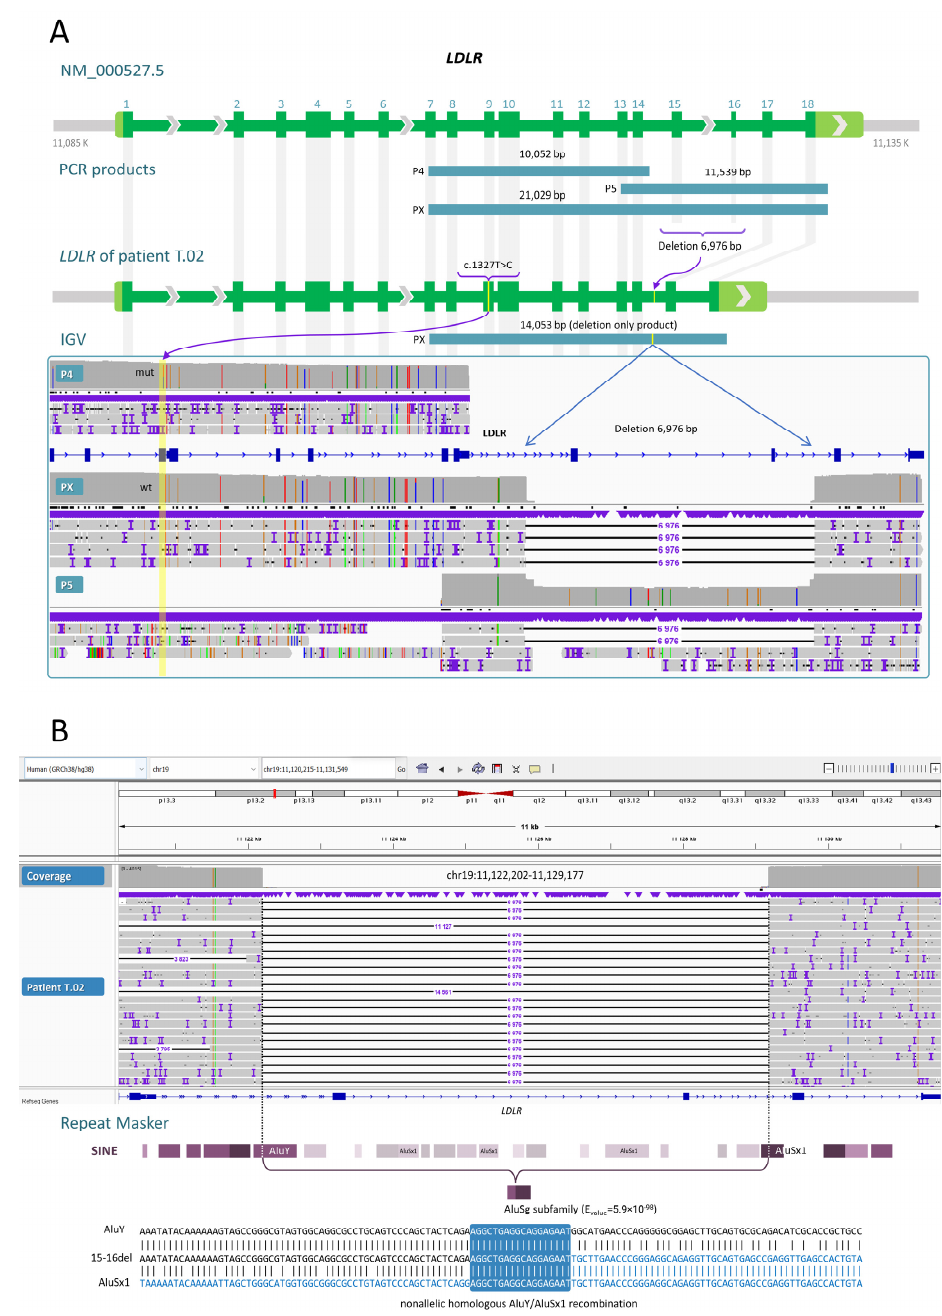
Figure 3. A snapshot from the IGV software showing the rare pathogenic variants of the LDLR gene in the T.02 sample. ( A ) ONT long reads identify a heterozygous state of the 6976 bp deletion that includes exons 15 and 16 (the amplicon of primer pair P5). Detection and phasing of missense variant c.1327T>C (wt/mut) relative to the 6976 bp deletion (amplicons of primer pairs P4, P5, and PX); ( B ) The precise location of breakpoints of the 6976 bp deletion and its DNA sequence are shown. The allele with the 6976 bp deletion has a higher probability of amplification with primer pair PX. Thus, only variant-containing reads are shown. Alu element homology is a possible cause of the deletion